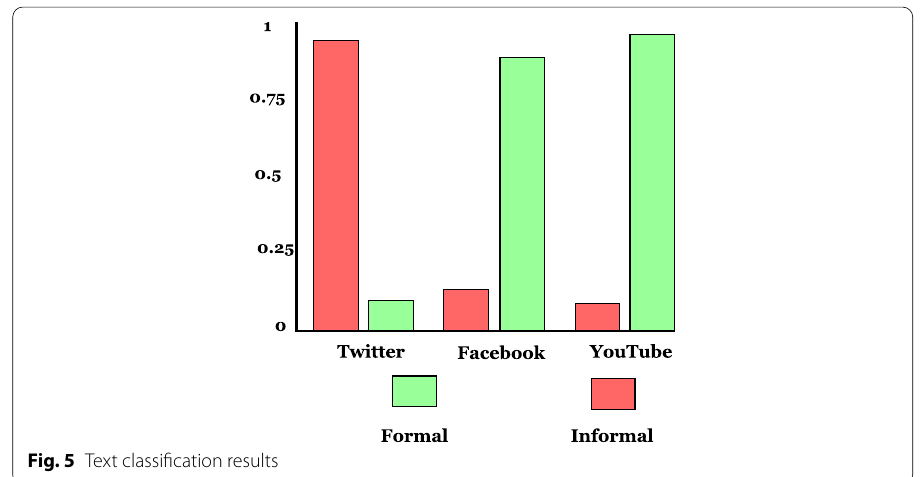
Fig. 5 Text classification